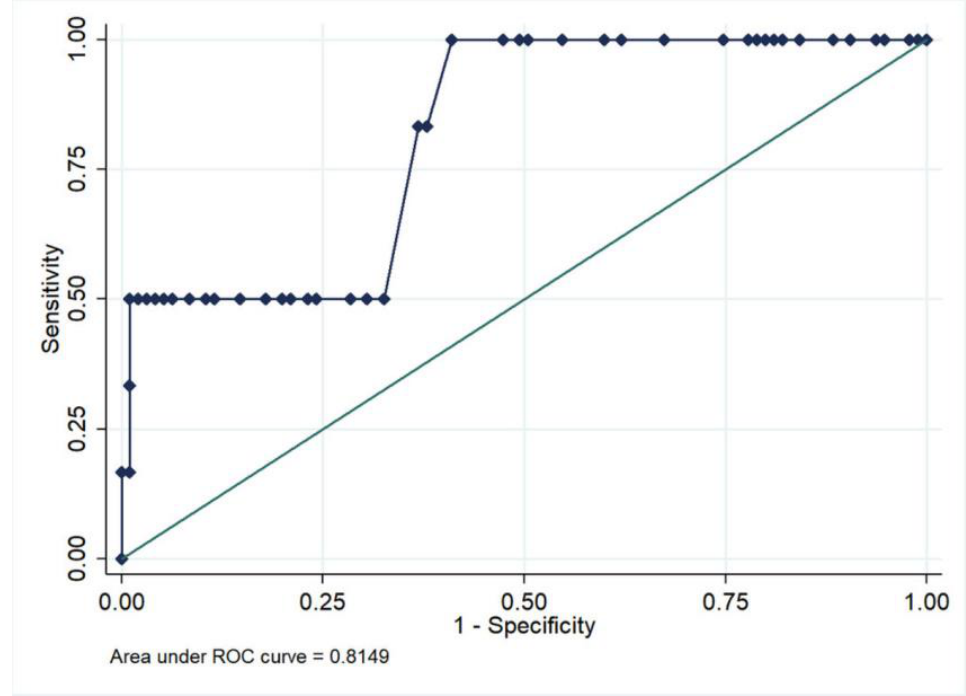
Figure 2. Accuracy of liver stiffness for the prediction of gestational hypertensive disorders in the overall cohort.